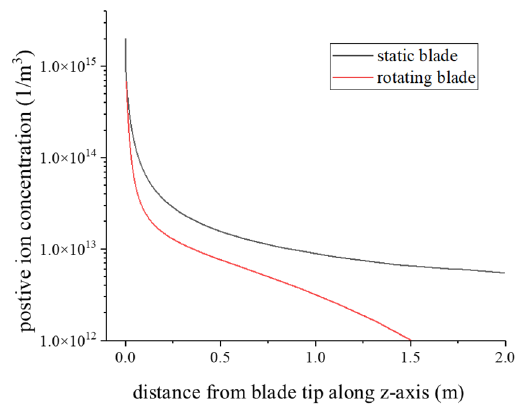
Figure 11. Comparison of positive ion distributions.